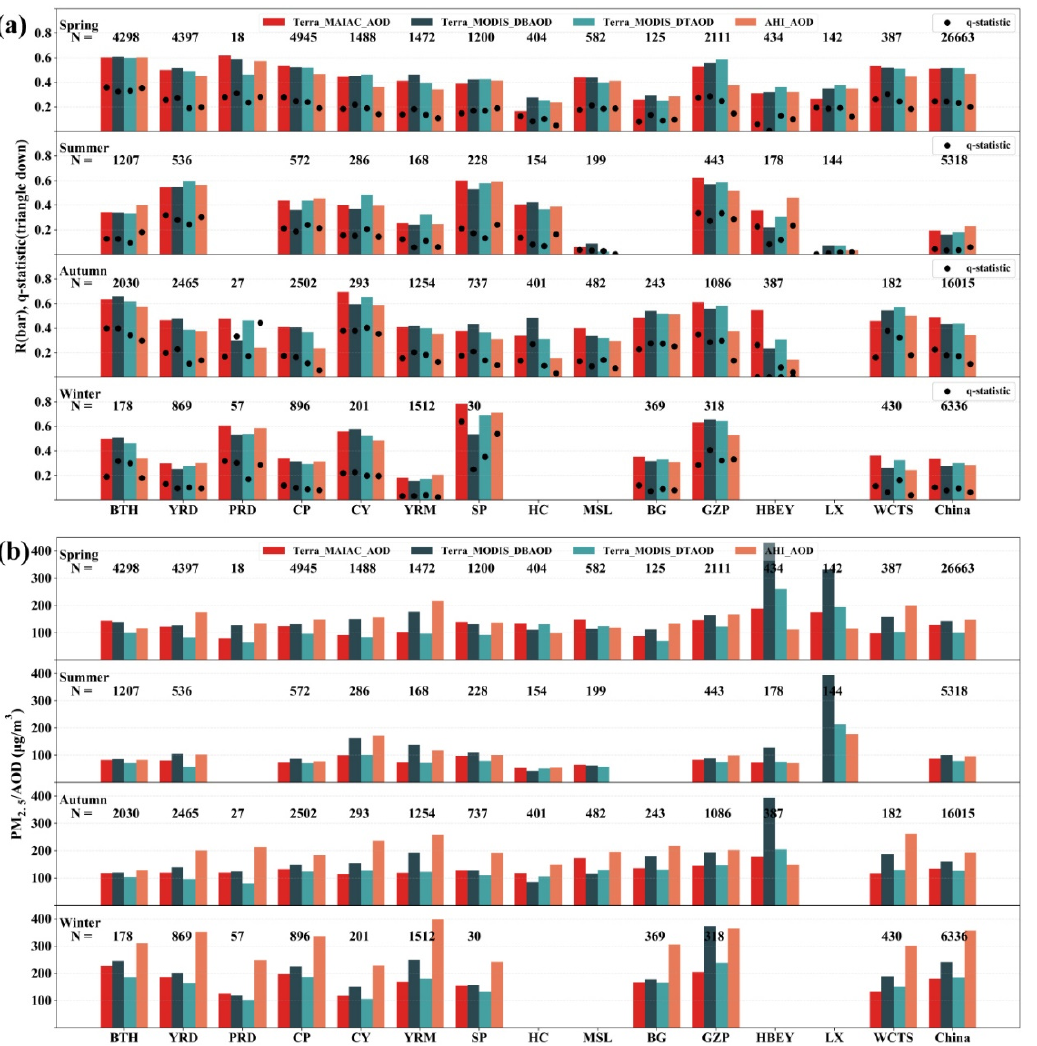
Figure 8. The relationship between Terra MAIAC AOD, Terra DT AOD, Terra DB AOD, AHI AOD, and the ground-level PM 2.5 concentration over China mainland and its typical regions over various seasons. ( a ) The correlation coefficient (bar) and the q statistic (black dots); ( b ) the ratio ( η ). Note that when calculating the η , the PM 2.5 concentration is the same for different AODs.